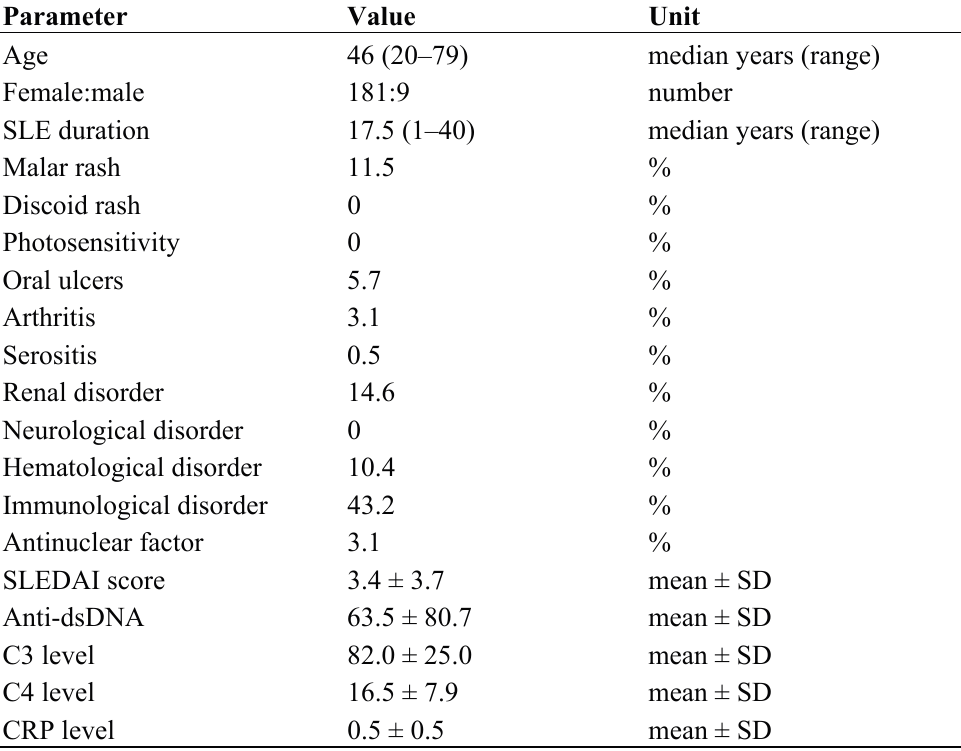
Table 1. Demographics and clinical parameters # of SLE patients recruited in the